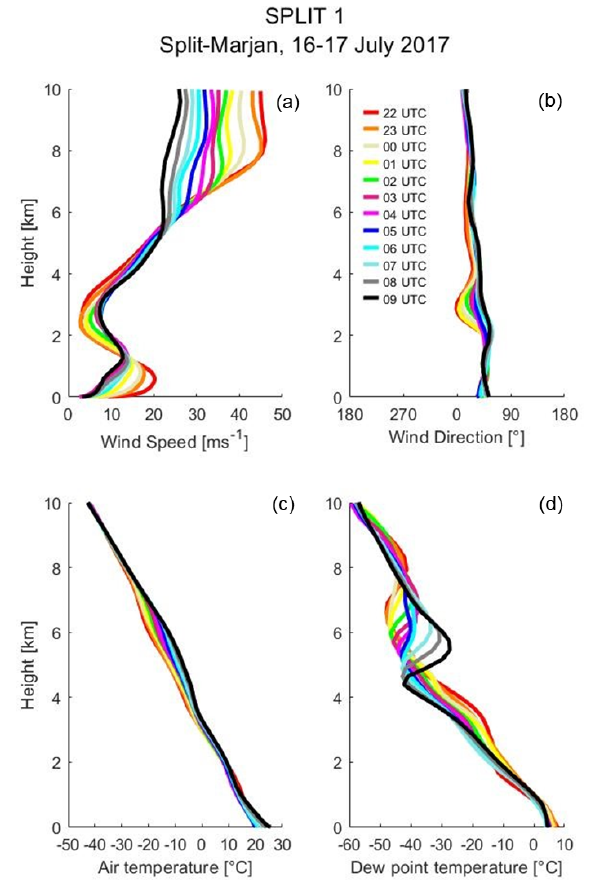
Figure 14. Vertical profiles of (a) wind speed (ms − 1 ), (b) wind direction ( ◦ ), (c) air temperature ( ◦ C), and (d) dew point temper- ature ( ◦ C) at Split-Marjan locations for the period SPLIT 1 (from 22:00UTC on 16 July 2017 to 09:00UTC on 17 July 2017) from the ALADIN model. See Fig. 2 for location of